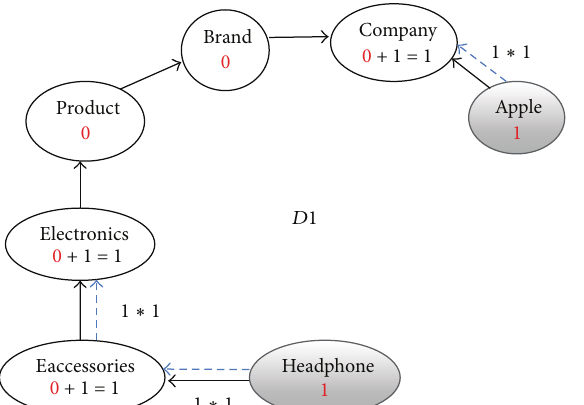
Figure 11: Spreading activation for 𝐷1 .